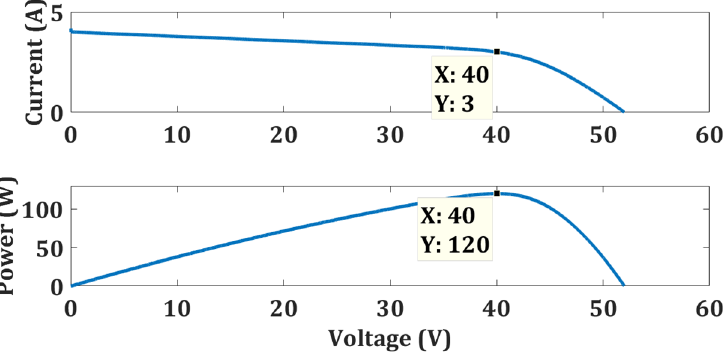
Figure 5. Characteristic curves of 4S PV array under zero shading.